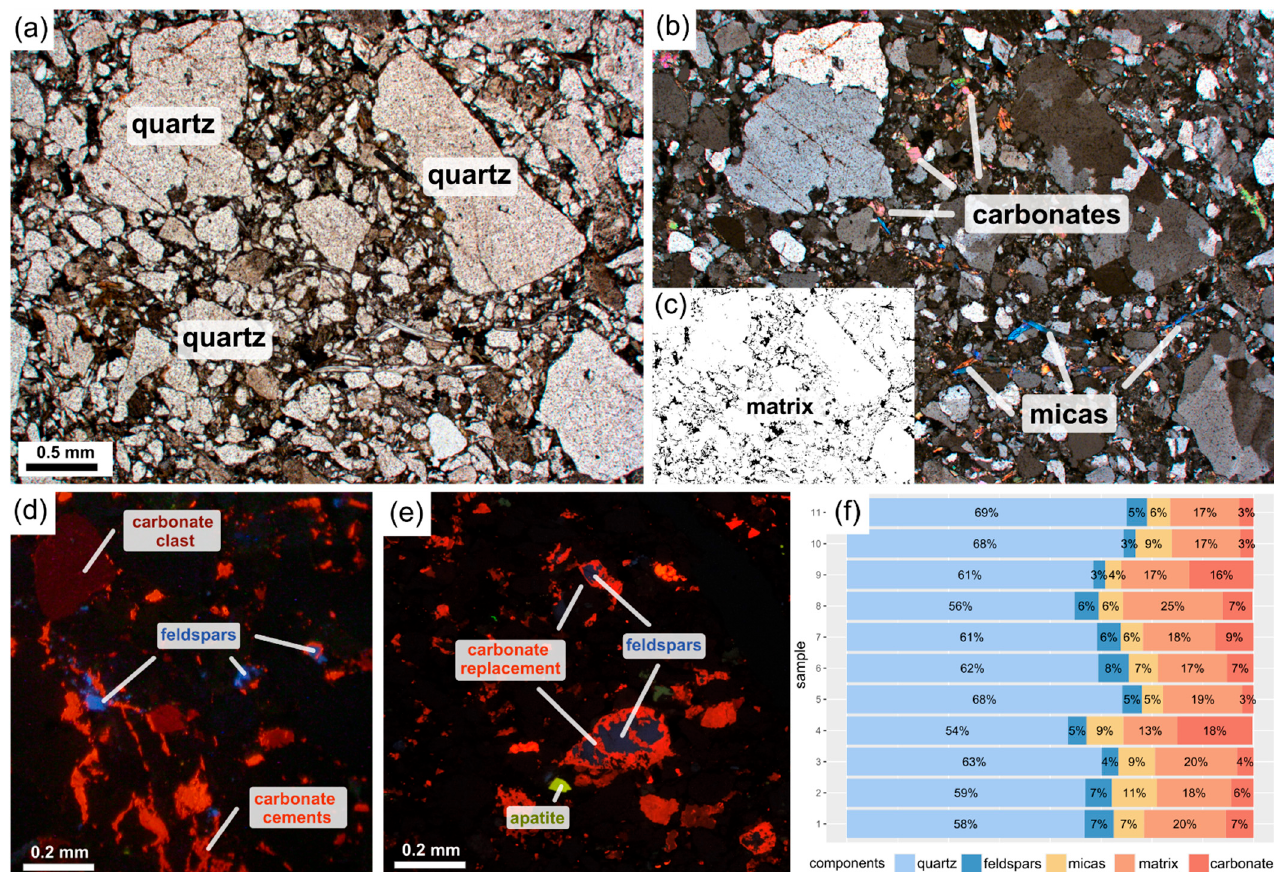
Figure 3. ( a ) Microphotographs showing rock composition and microstructure corresponding to the sampled rock shown in the plane-polarised light and ( b ) cross-plane polarized light; ( c ) A mask of the matrix extracted from Figure 3a; ( d , e ) the cathodoluminescence microphotographs showing the mineral composition of the sample; ( f ) Results of the mineral composition determination using the point-count method on the corresponding thin sections.